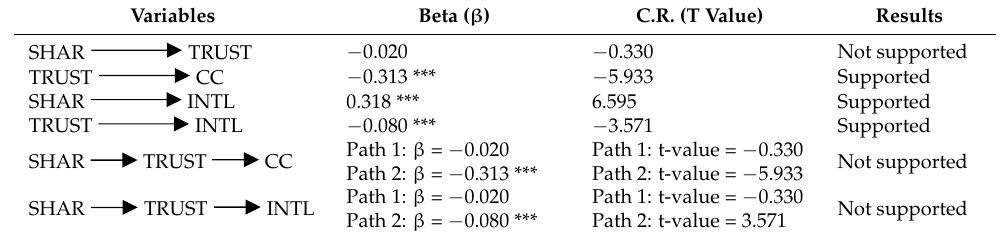
Figure 2. The final structural model. Trust = Trust in Superiors; SHAR = Sexual Harassment by Superiors; CC = Continuous Commitment; INTL = Intention to Leave; *** = p < 0.001; NS = Not Significant; Model fit: ( χ 2 (85, N = 305) = 330.766, p < 0.001, normed χ 2 = 3.987, RMSEA = 0.024, SRMR = 0.136, CFI = 0.980, TLI = 0.978, NFI = 0.988, PCFI = 0.981 and PNFI = 0.970. Table 4. The results of direct relationship. Variables Beta ( β ) C.R. ( T Value ) Results